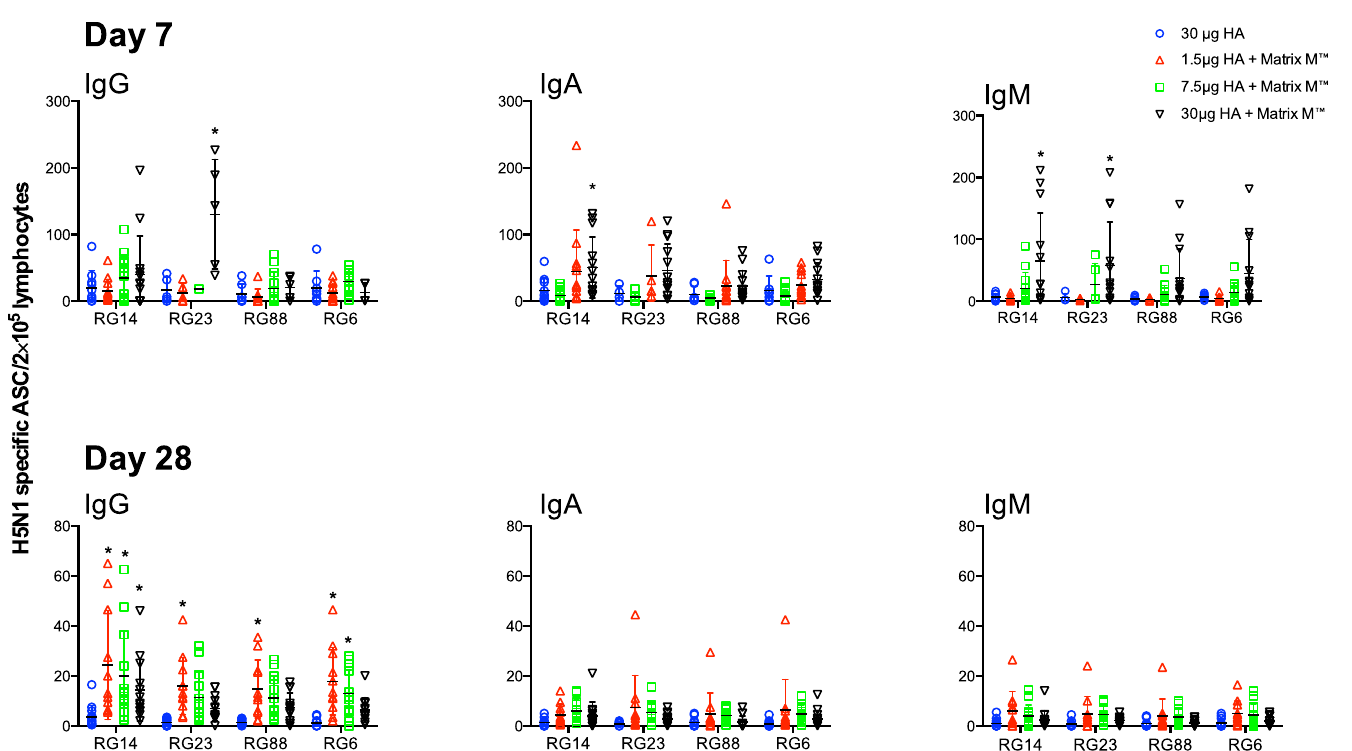
Fig 8. The antibody secreting cell response induced after influenza vaccination. Lymphocytes were collected 7 days after the first (day 7) and second vaccine dose (day 28) of inactivated virosomal H5N1 vaccine alone or formulated 1.5, 7.5 or 30 μ g HA formulated with Matrix-M (50 μ g). The influenza-specific IgG, IgA and IgM antibody secreting cells (ASC) were enumerated using the ELISPOT assay. The data are presented as the mean number of influenza- specific ASC per 200 000 lymphocytes ± standard error of the mean to the homologous vaccine strain A/Vietnam/1104/2004 (NIBRG-14), and the heterologous responses to A/Turkey/Turkey/1/05 (NIBRG-23), A/Cambodia/R0405050/2007 (NIBRG-88) and A/Anhui/1/05 (RG6). Statistical differences between the adjuvanted and non-adjuvanted groups were calculated by ANOVA with Dunnett ’ s multiple comparisons test. * p <